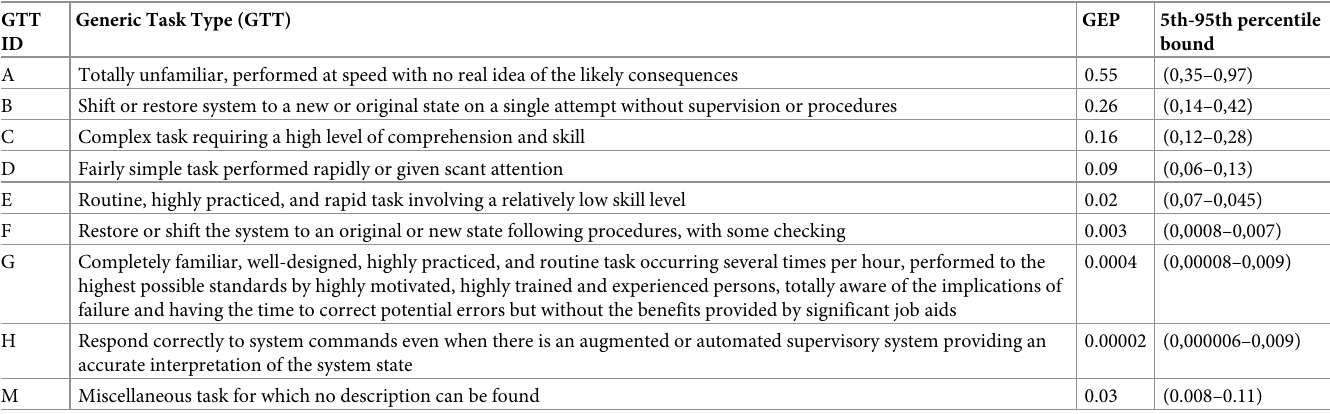
Table 1. Generic Task Type descriptions and GEP